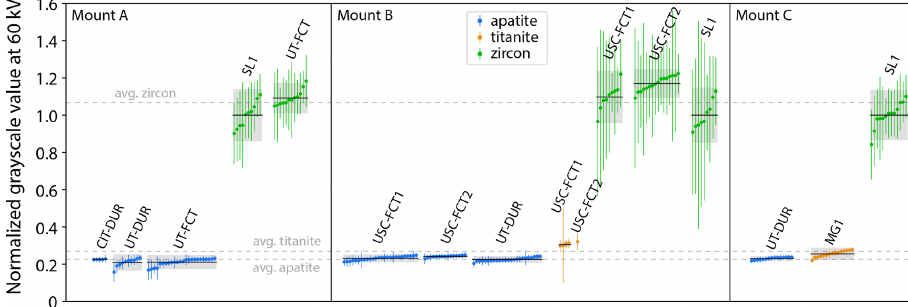
Figure 5. Mean grayscale values (normalized by SL1 zircon) for all grains measured in 60kV/68min scans, given with 2 σ variability and organized by mount and sample. Zircon is shown in green, apatite in blue, and titanite in orange, as in the other figures. The average for each sample is given as a black bar with the 2 σ variability shaded in gray. Averages for the whole populations of apatites, zircons, and titanites are given as gray dashed lines. Zircon and apatite populations for all mounts are distinct, while apatite and titanite populations show some overlap. There is observable inter-sample variability in the mean normalized grayscale value of each mineral but values for the same samples (e.g., UT-DUR) are reproducible within error between mounts.